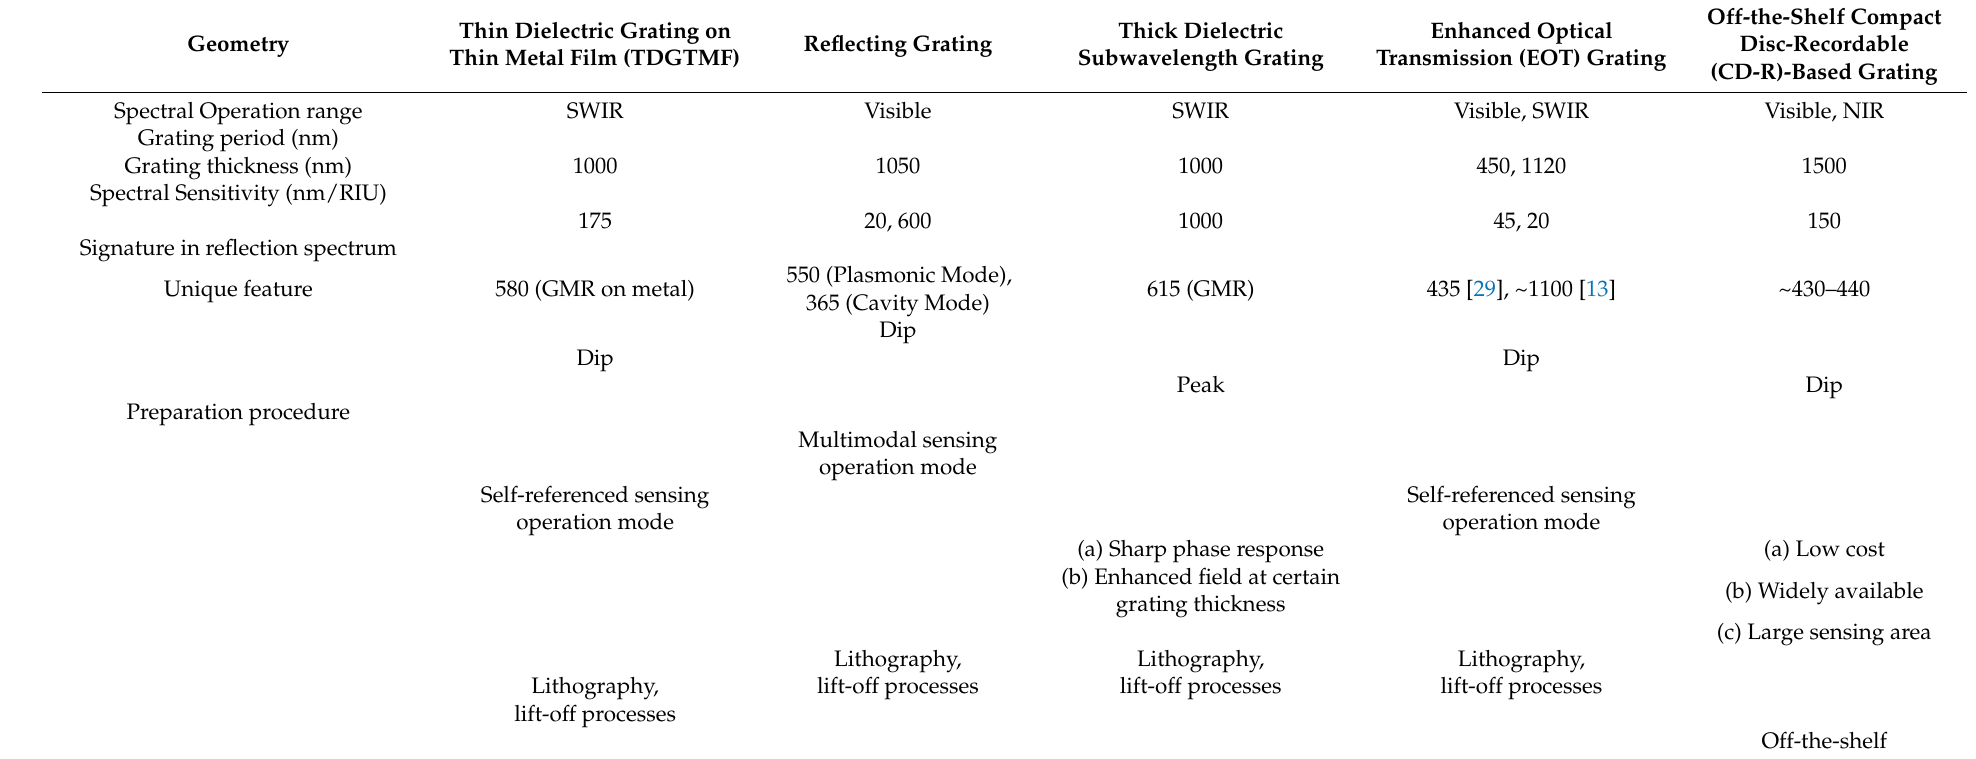
Table 1. Summary of the parameters and unique features of all the grating-based